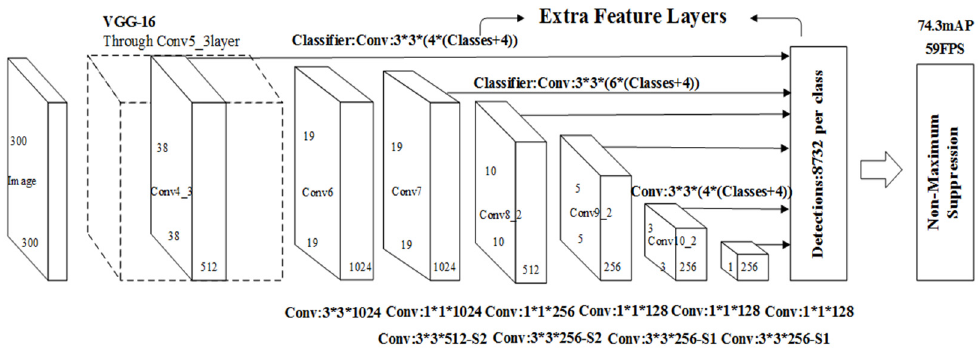
Figure 11. SSD network structure.